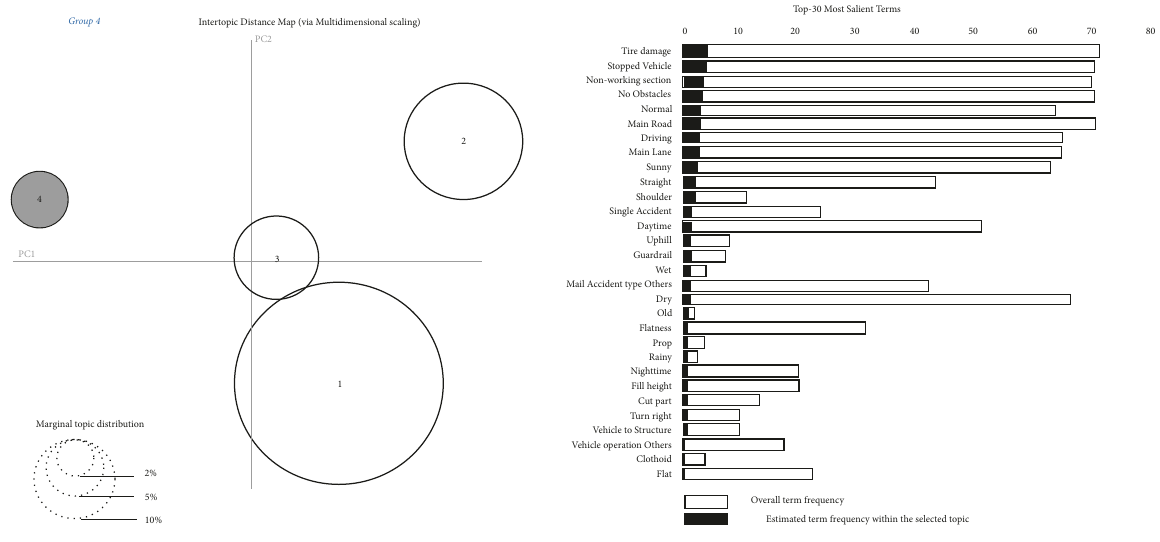
Figure 9: Vehicle factor group 4.